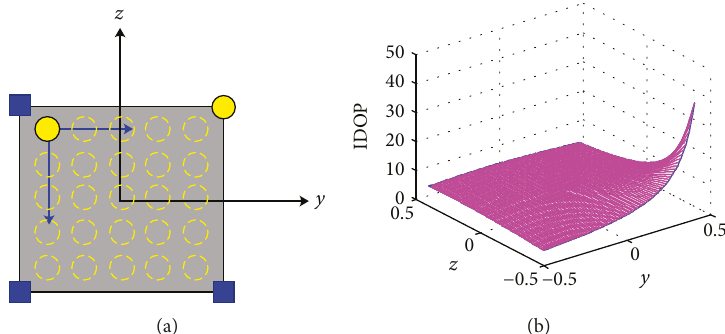
Figure 13: The traversal model and history of the IDOP: (a) the traversal model; (b) IDOP obtained by traversal